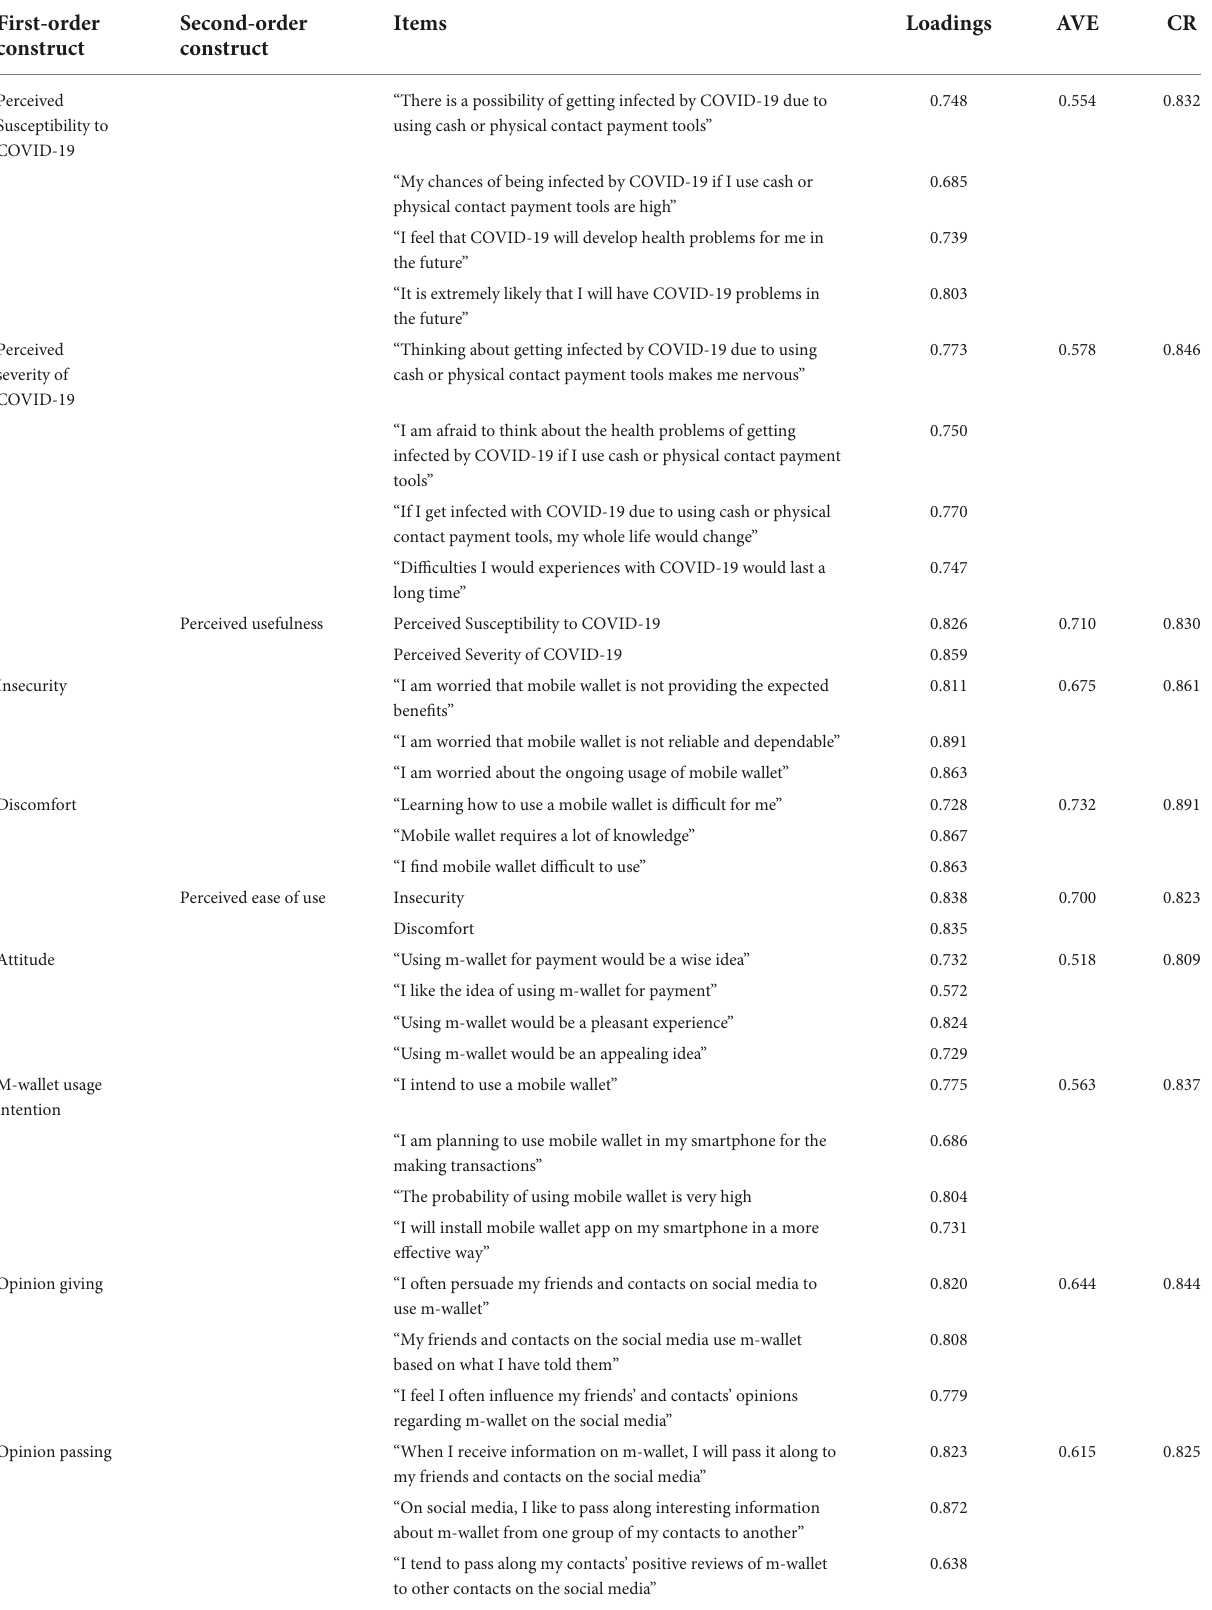
TABLE 3 Measurement